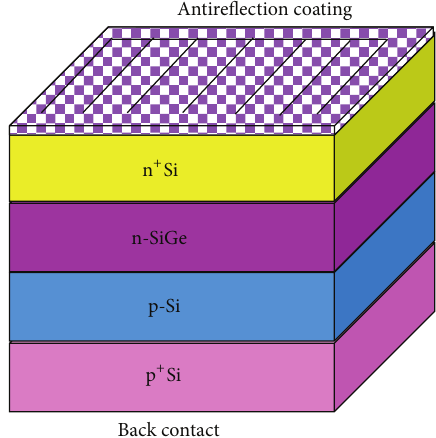
Figure 5: Schematic structure of Si/SiGe heterojunction solar